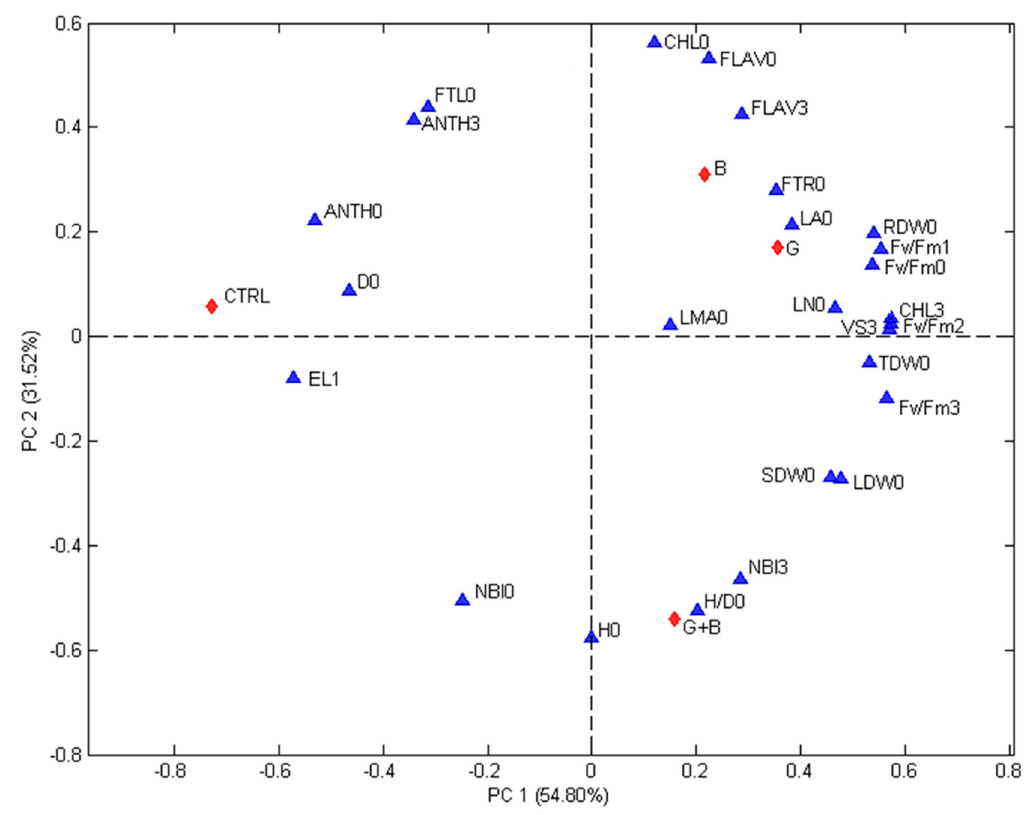
Figure 4. Biplot of Principal Component Analysis results on second experiment.